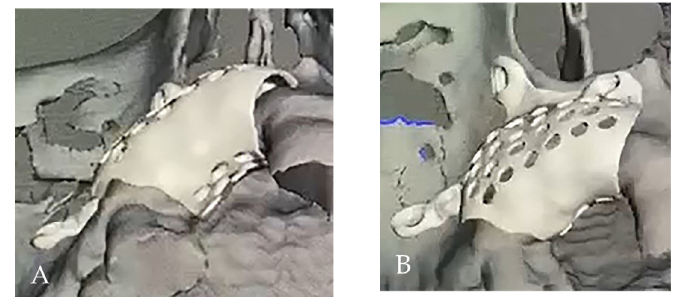
Figure 4. The digital design: ( A ) occlusal view, ( B ) palatal and buccal view.